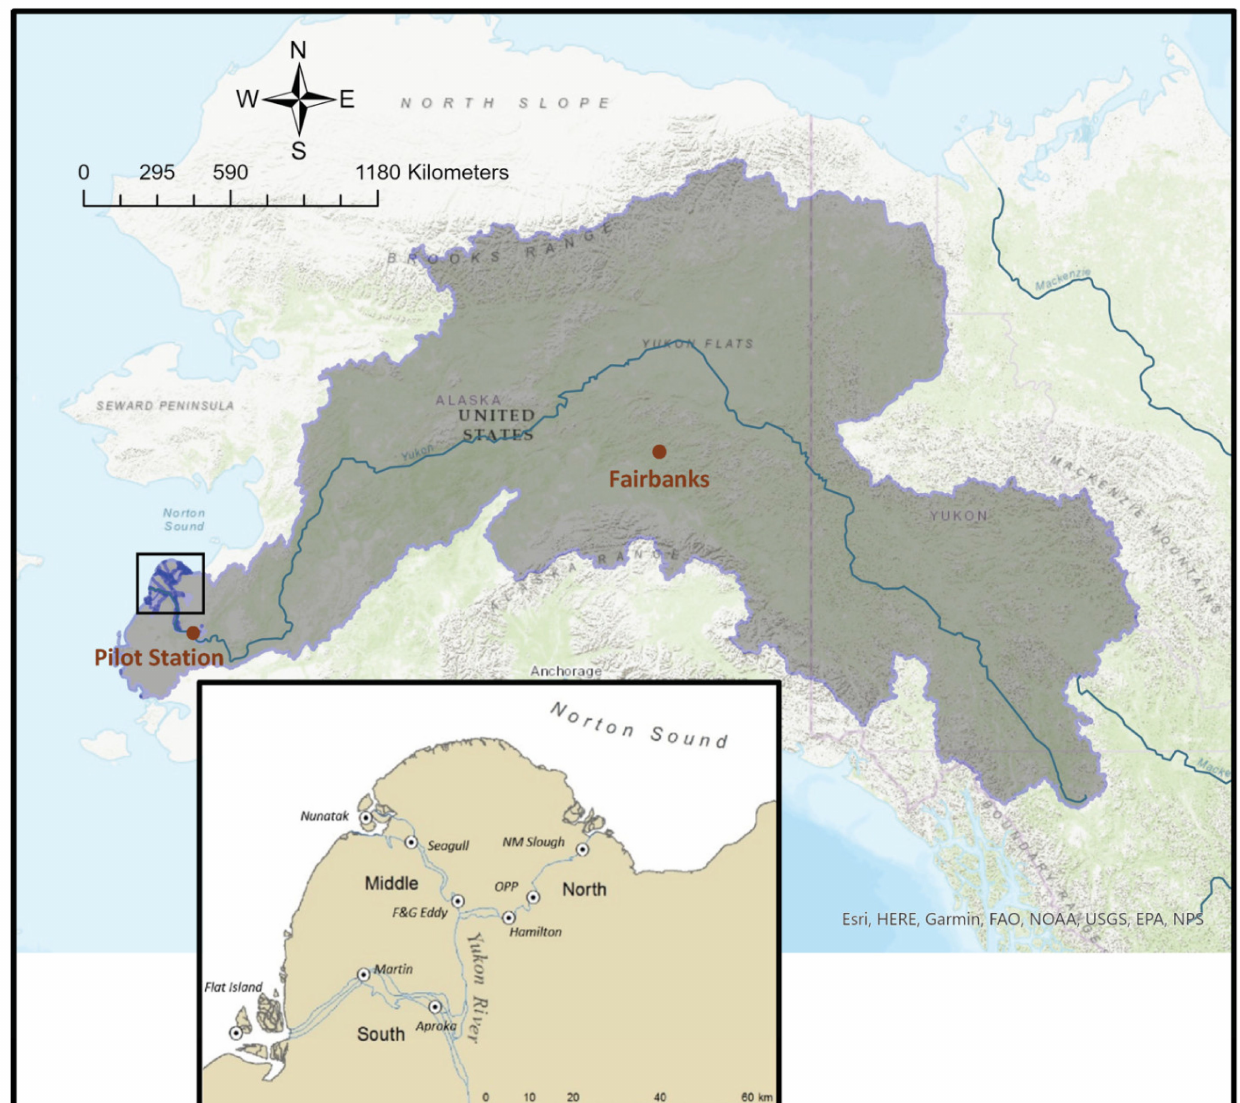
Figure 1. Map of the Yukon River Basin (gray) showing the location of the USGS gauge at Pilot Station and Fairbanks. Black box corresponds to the inset showing the study area. Black circles are the nine permanent biological sampling